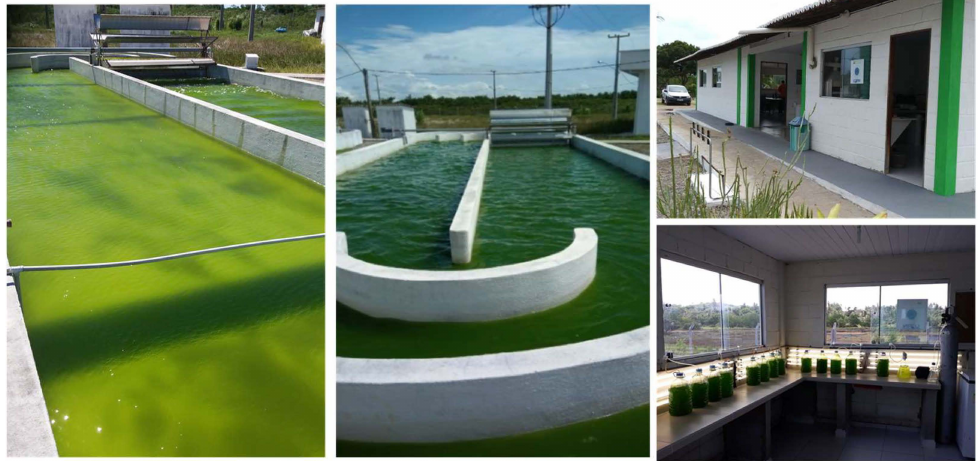
Figure 4. Petrobras pilot-scale open pond microalgae production facility in Rio Grande do Norte